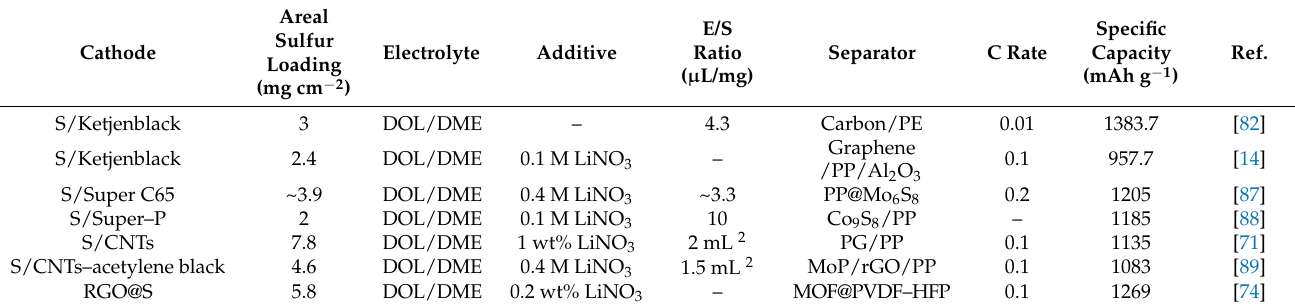
Table 4. Performance Li–S pouch cells 1 with novel